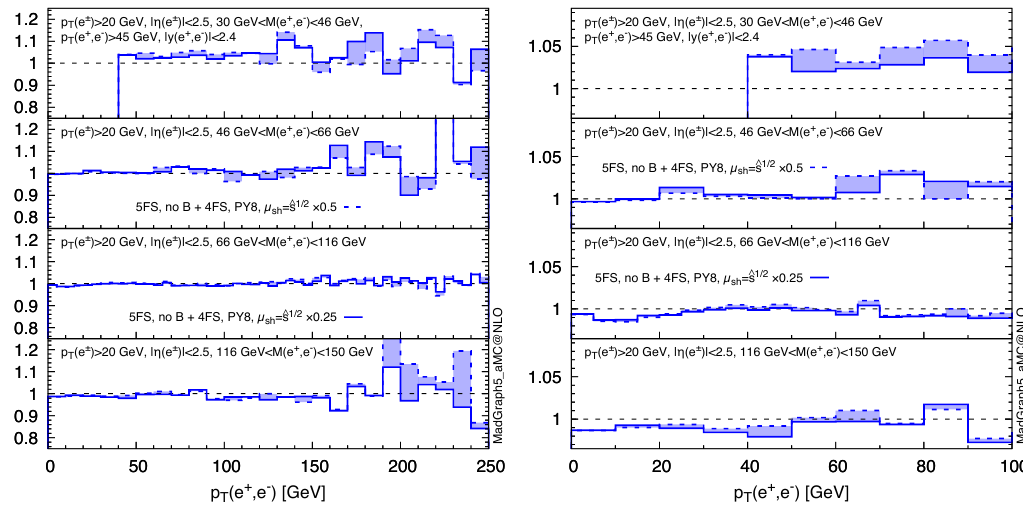
Figure 11 . Ratio of the p ‘ + ‘ (cid:0) distribution in the re(cid:12)ned approximation including the bottom- ? quark mass e(cid:11)ects over the plain 5FS, in di(cid:11)erent bins of the lepton-pair invariant mass. The plot on the left is a zoom on the low- p ‘ + ‘ (cid:0) region of the plot on the right. ?